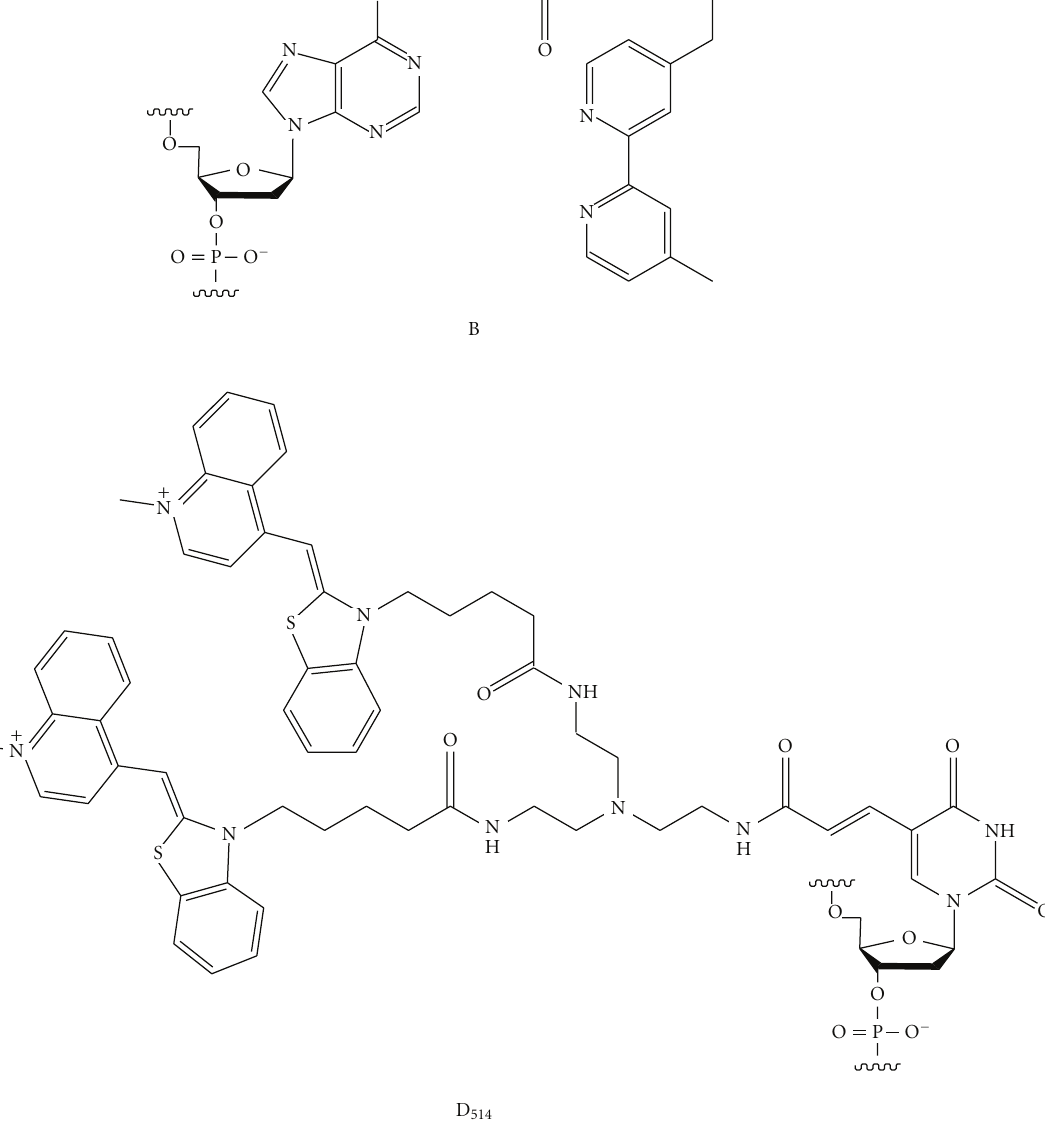
Figure 1: Structures of the “B” nucleotide of the ICON probe for 5-methylcytosine selective crosslink formation and the “D 514 ” nucleotide of the Exciton primer for real-time PCR